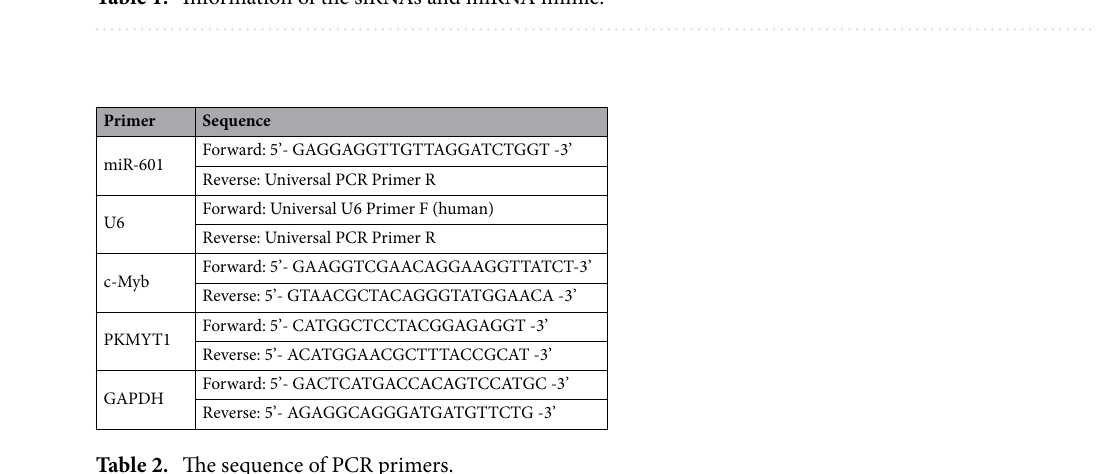
Table 1. Information of the siRNAs and miRNA mimic.